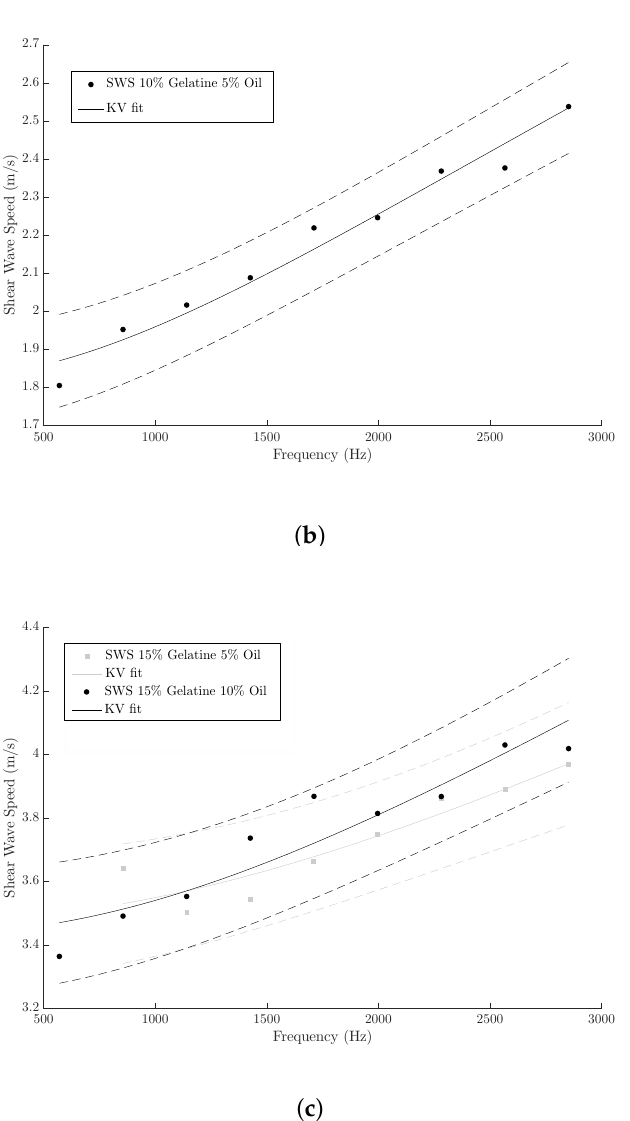
Figure 9. Dispersion curve for each batch of gelatine (shear wave speed data points acquired from Verasonics). The curves for Kelvin-Voigt model (solid black lines) and 95% confidence intervals (dashed lines) are shown. ( a ) Batches 7.5% gelatine 5% oil and 7.5% gelatine 10% oil; ( b ) Batch 10% gelatine 5% oil; ( c ) Batches 15% gelatine 5% oil and 15% gelatine 10%